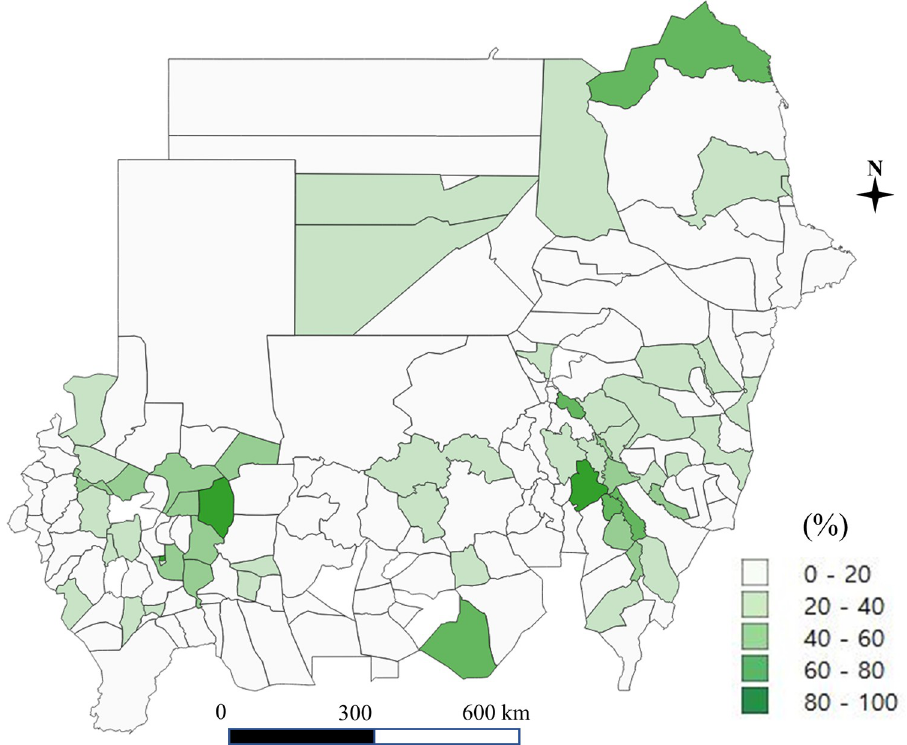
Fig 4. Having water and soap at the school level (the authors generated the